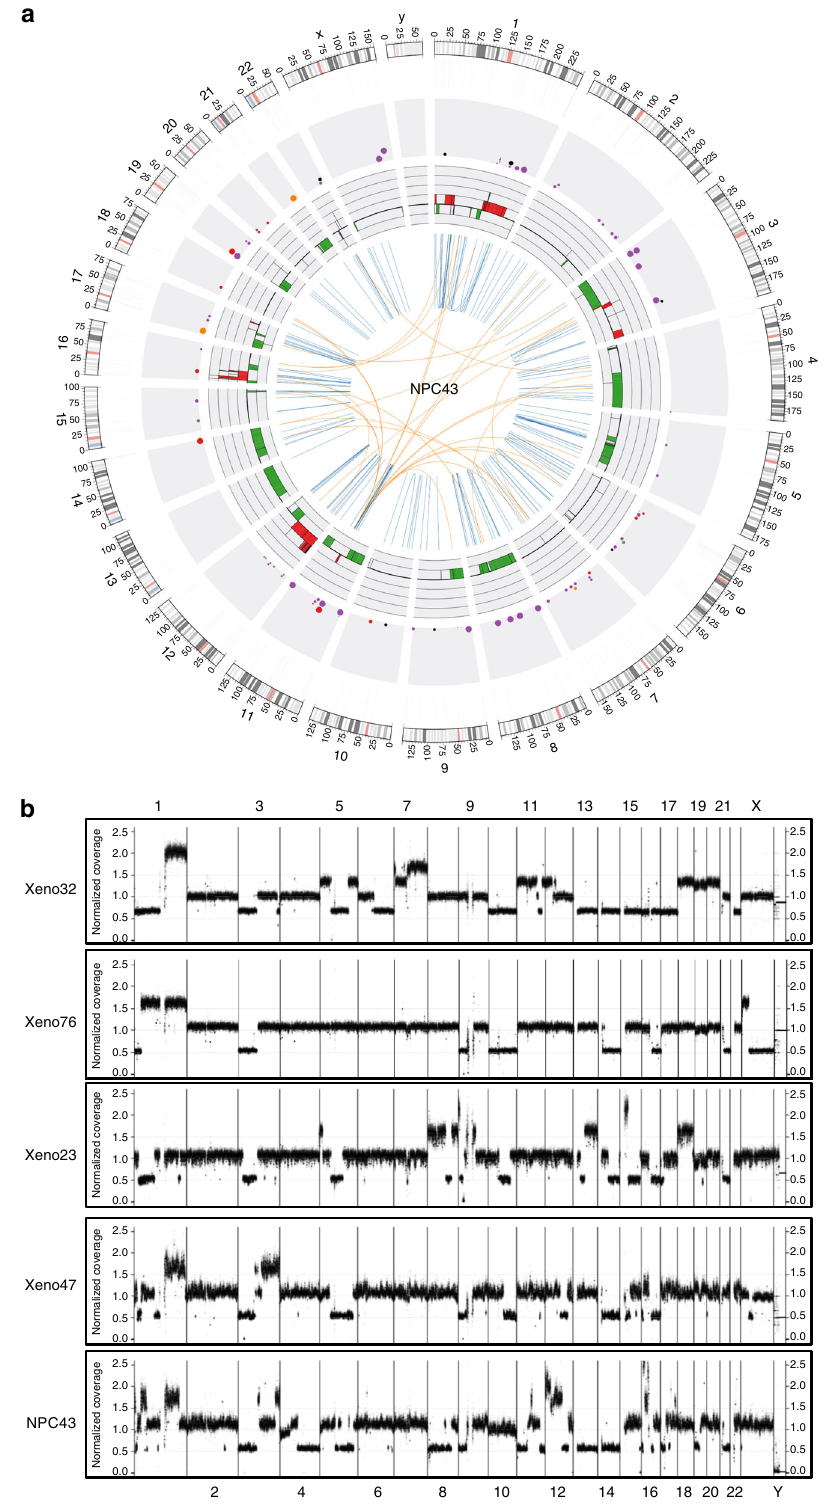
Fig. 7 Genetic landscape of newly established NPC tumor lines. a Circos plot showing genomic aberrations in NPC43 by WGS. Illustrations in order from inner to outer rings: (1) structural variants (orange, inter-chromosomal rearrangement; blue, intra-chromosomal rearrangement), (2) copy number alterations (green, copy number loss; red, copy number gain; range: − 2 to + 4), (3) non-synonymous single-nucleotide variants or small indels (purple, missense; black, splicing; orange, nonsense; red, frameshift; green, inframe indel; brown, others) with allele frequency indicated by the size of each dot (0, 20, 40, 60, 80, 100% or more), (4) density of SNVs/small indels (0, 20, 40, 60, 80, 100, 120, 140, 160 per Mbps or more), (5) chromosome scale at 1 Mbps (shades of gray, cytobands; red, centromere). High-resolution plot is illustrated in Supplementary Fig. 14. b Whole-genome pro fi les of chromosome copy number alterations in NPC PDXs/cell line. Overall normalized coverage across genome is shown on vertical axis